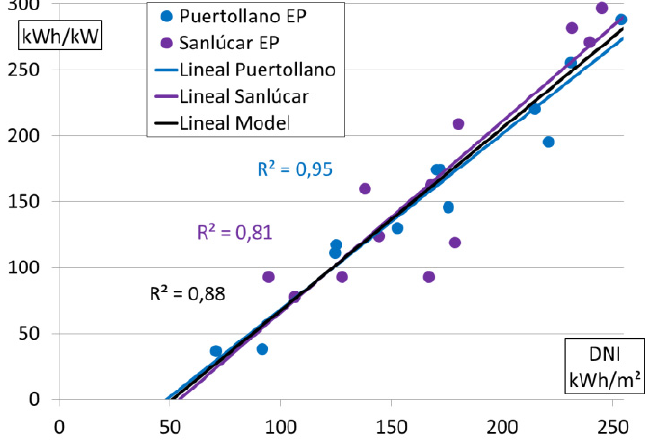
Figure 11. Correlation between monthly EP and monthly estimated DNI at the Puertollano and the Sanlúcar CPV installations (individual installations and the combined